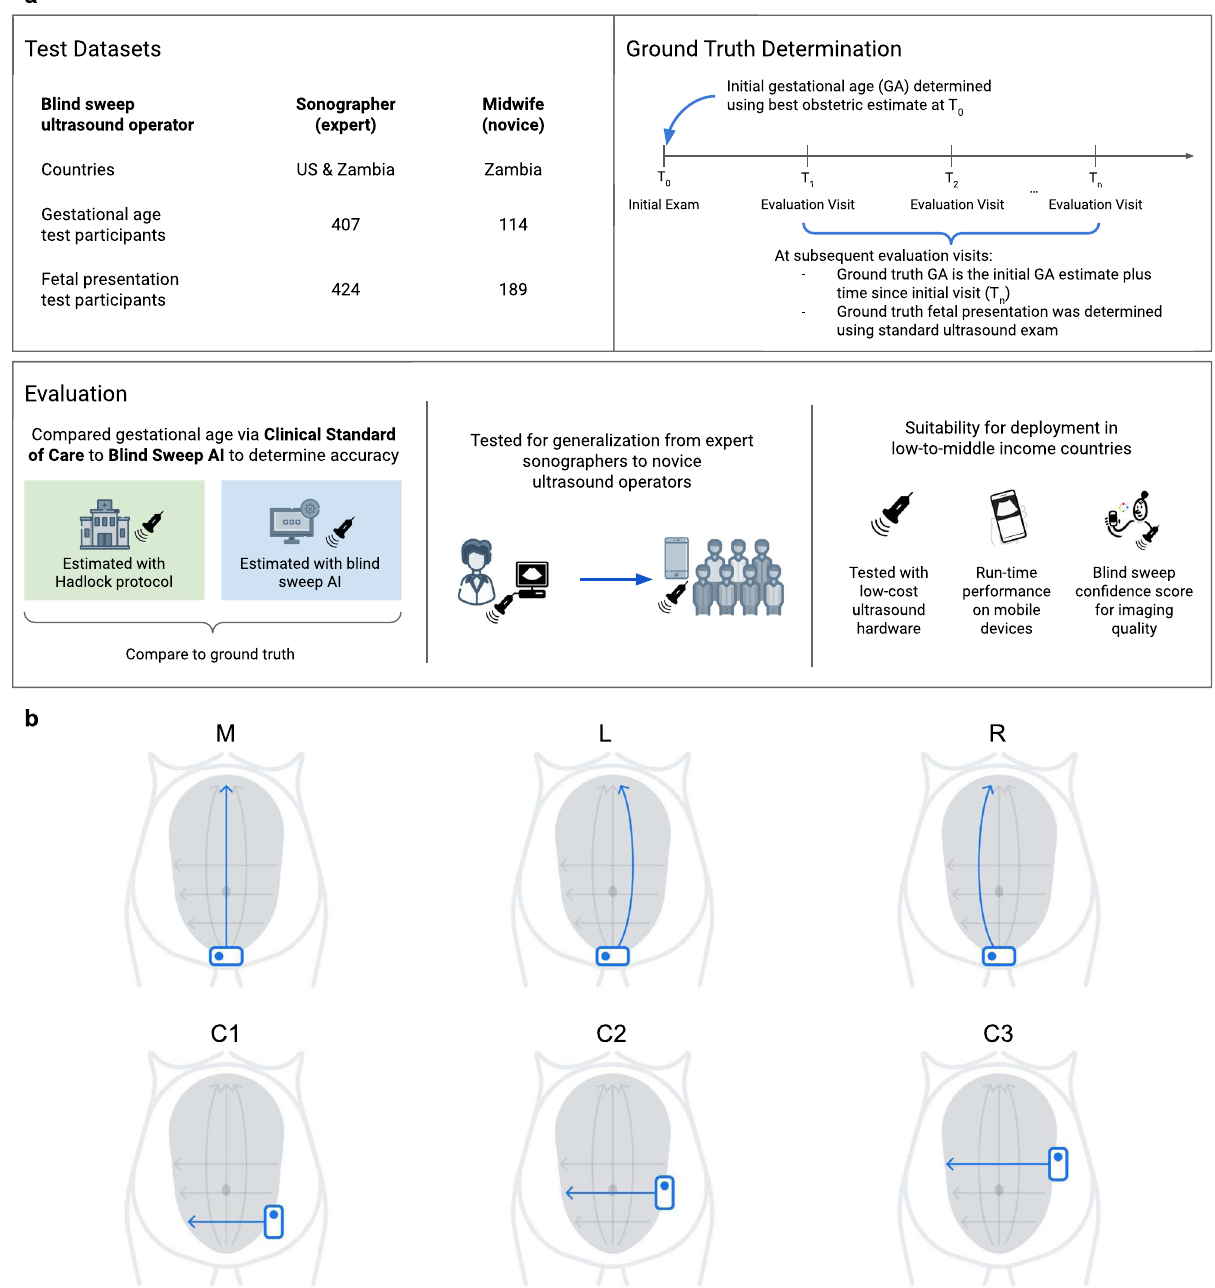
Fig. 1 Development of an arti fi cial intelligence system to acquire and interpret blind-sweep ultrasound for antenatal diagnostics. a Datasets were curated from sites in Zambia and the USA and include ultrasound acquired by sonographers and midwives. Ground truth for gestational age was derived from the initial exam as part of clinical practice. An arti fi cial intelligence (AI) system was trained to identify gestational age and fetal malpresentation and was evaluated by comparing the accuracy of AI predictions with the accuracy of clinical standard procedures. The AI system was developed using only sonographer blind-sweep data, and its generalization to novice users was tested on midwife data. Design of the AI system considered suitability for deployment in low-to- middle-income countries in three ways: fi rst, the system interpreted ultrasound from low-cost portable ultrasound devices; second, near real-time interpretation is available of fl ine on mobile phone devices; and fi nally, the AI system produces feedback scores that can be used to provide feedback to users. b Blind-sweep ultrasound acquisition procedure. The procedure can be performed by novices with a few hours of ultrasound training. While the complete protocol involves six sweeps, a set of two sweeps (M and R) were found to be suf fi cient for maintaining the accuracy of gestational age estimation. Cases consisted of multiple blind-sweep videos, and our models sequences corresponded to a single complete blind sweep. We then generated predictions independently for each video sequence within aggregated the predictions to generate a single case-level estimate for the case. For the GA model, each blind sweep was divided into either GA or fetal malpresentation (described further in the Mobile multiple video sequences. For the fetal malpresentation model, video Device Inference section in supplementary materials).